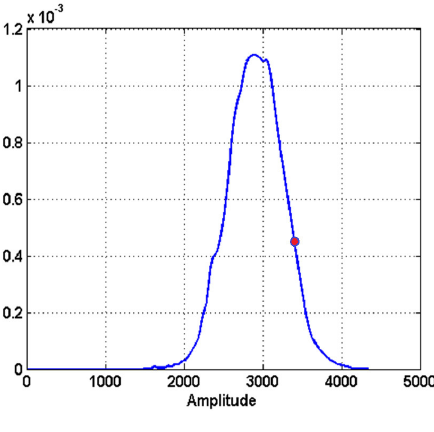
Figure 6. Sea clutter.